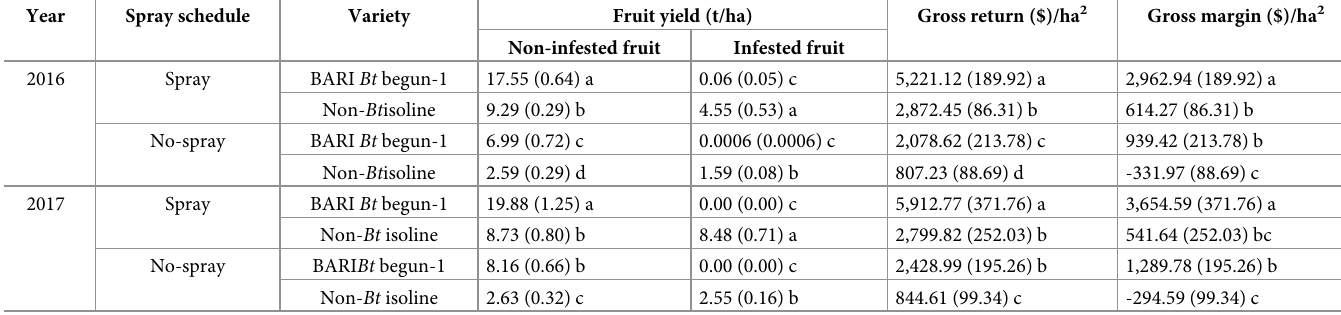
Table 7. Mean yields and economic returns 1 in brinjal by brinjal shoot and fruit borer (BFSB) relative to insecticides and varieties, OFRD, BARI, Bogra, Bangladesh.